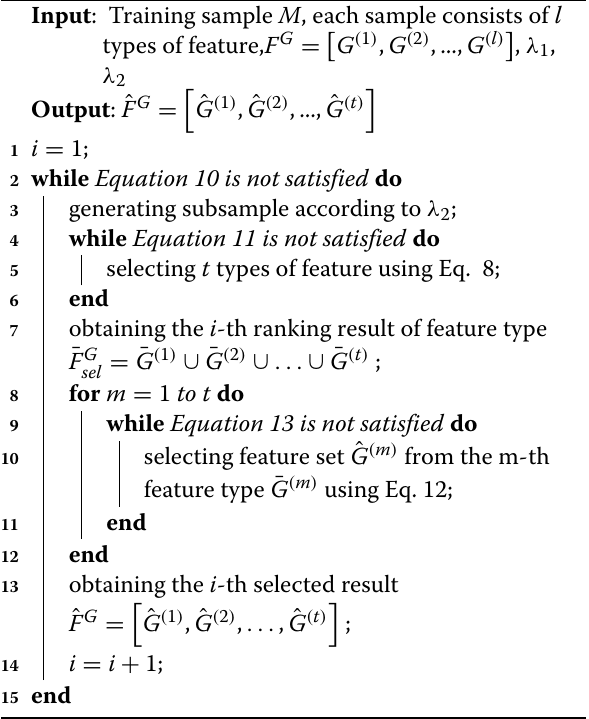
Algorithm 1: SIP-FS via feature type selection and stability